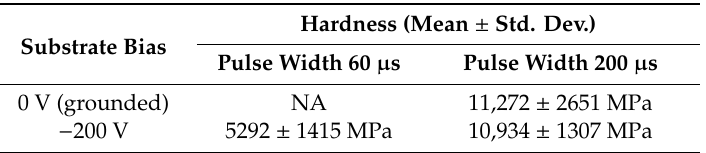
Table 3. Comparison of nanoindentation hardness of Cr films deposited by using di ff erent HiPIMS pulse widths and substrate bias